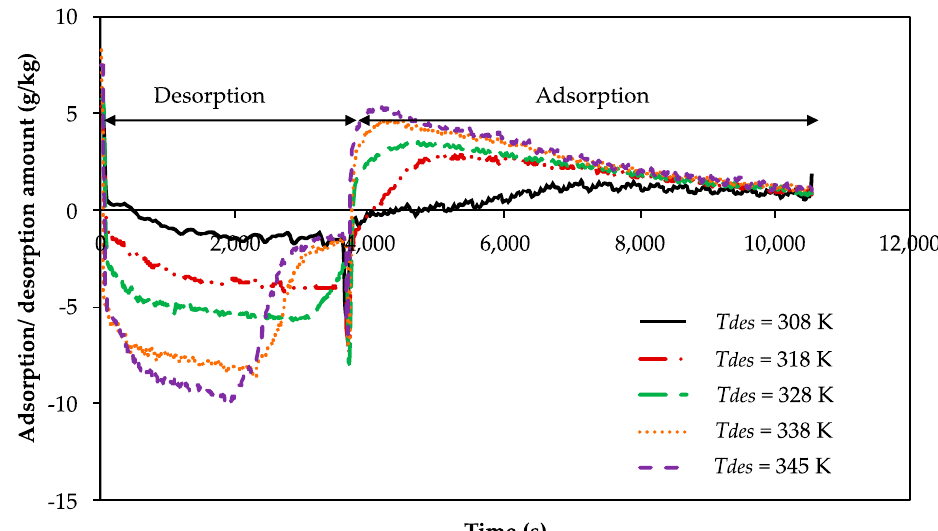
Figure 3. Water content removal during adsorption/desorption processes for different desorption temperatures.